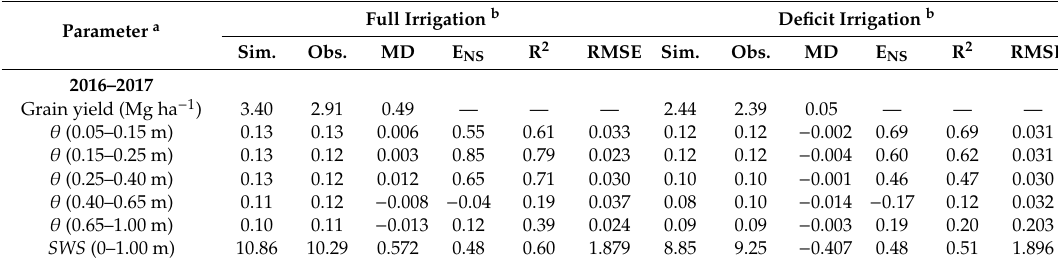
Table 4. Statistics of comparison for simulated versus measured crop yield and soil moisture over two years for full irrigation (D-FI) and deficit irrigation (D-DI).